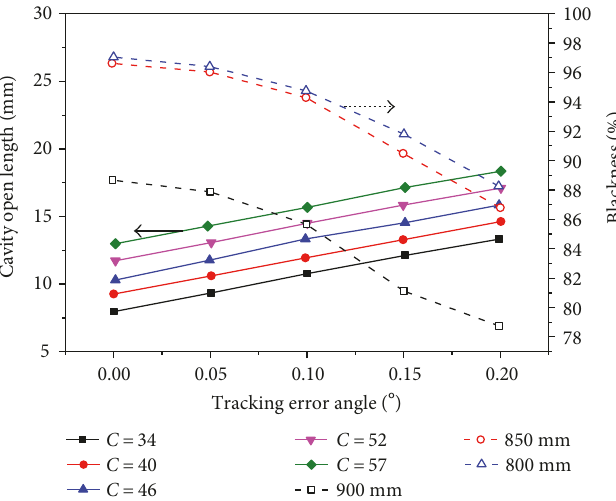
Figure 6: The cavity blackness under di ff erent tracking error angles, cavity open lengths, concentration ratios, and PTC focal